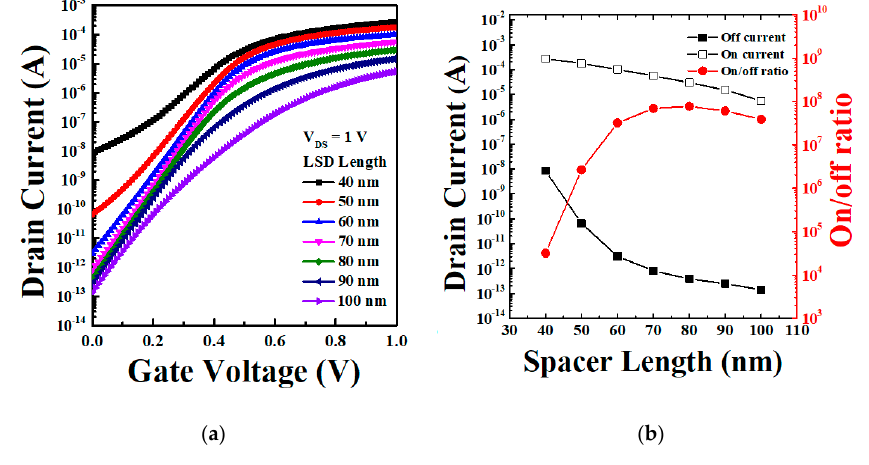
Figure 2. ( a ) Transfer curve; and ( b ) on/off current characteristics of N-type bulk FinFET according to spacer length.